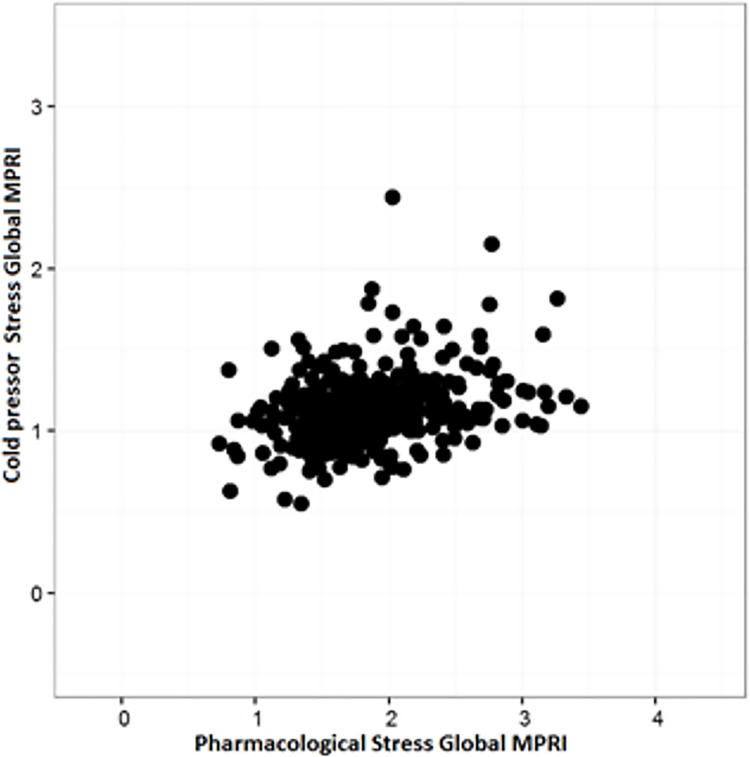
Correlation between CPT MPRI and pharmacological MPRI.